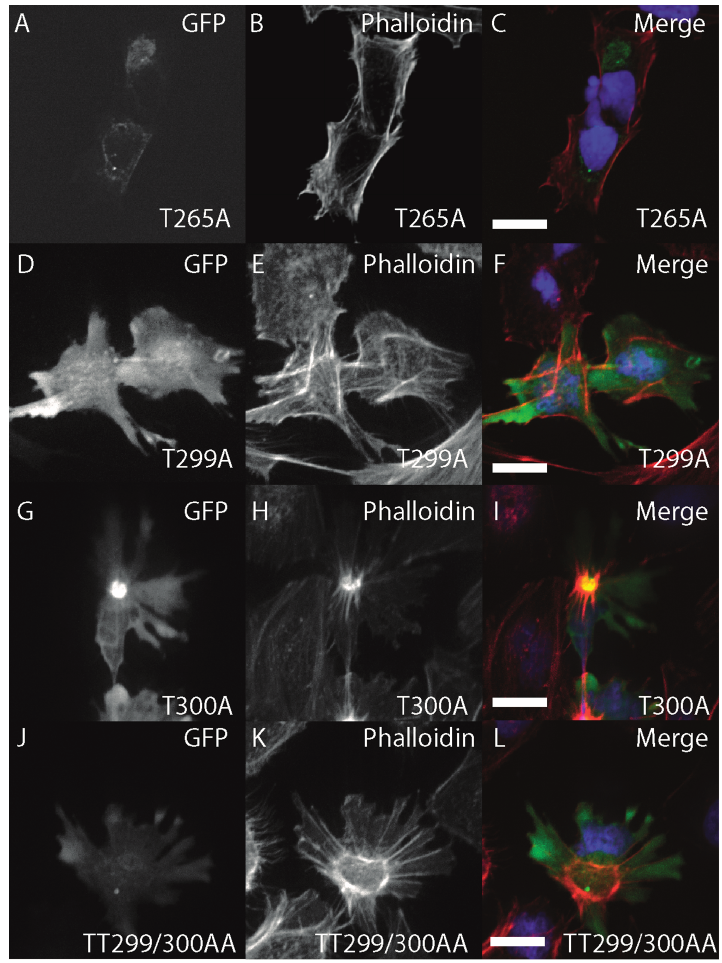
Figure 7. Structure-function of zebrafish ZIPK. HeLa cells were transfected with either GFP-ZIPK constructs generated by site-directed mutagenesis mutating a proposed activating phosphorylation site T265 or phosphorylation sites involved in controlling subcellular localization in the human paralog T299 and T300. All cells were fixed and stained with DAPI and Alexa 568-phalloidin. ( A , D , G , J ) show phalloidin staining; ( B , E , H , K ) show GFP; while color images ( C , F , I , L ) are a merge of DAPI (blue), GFP (green) and phalloidin (red). Each experiment was performed at least five times with a minimum of 25 cells assayed per experiment. White bar indicates 20 μ